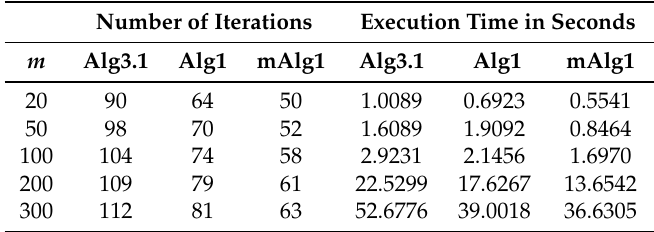
Figure 13. Example 4: Algorithm 1 (mAlg1) numerical comparison with Algorithm 3.1 (Alg3.1) in [39] and Algorithm 1 (Alg1) in [38] while m = 300.